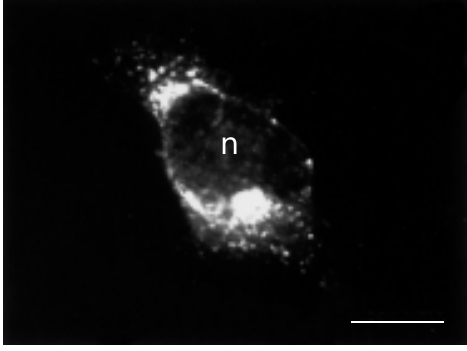
Figure 5 - COS-1 cells trans- fected with cDNA encoding the sst2A somatostatin (SRIF) recep- tor and incubated for 30 min with intracellular labeling pattern, seen here after wash-out of sur-